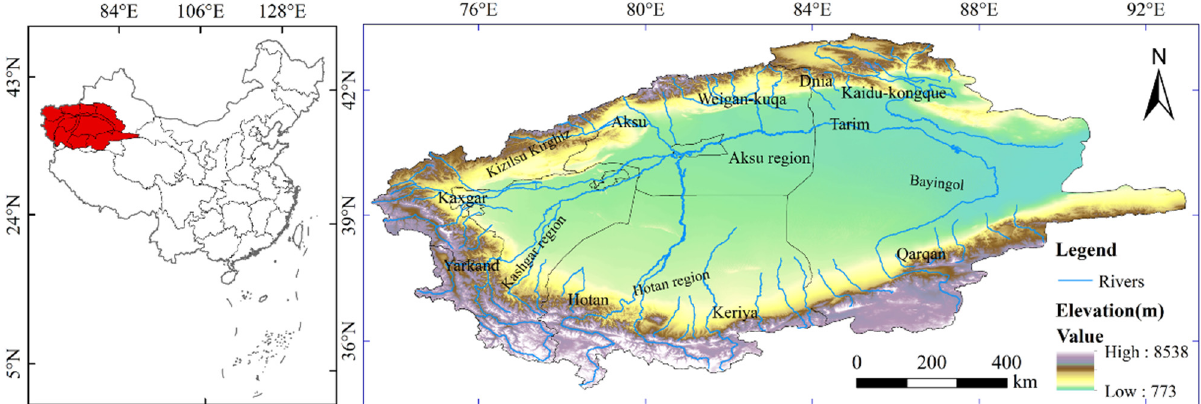
Figure 1. Sketch map of the Tarim River Basin, China. The map is from the Chinese Standard Map (http://bzdt.ch.mnr.gov.cn/GS (accessed on 11 April 2022) (2019)1822).